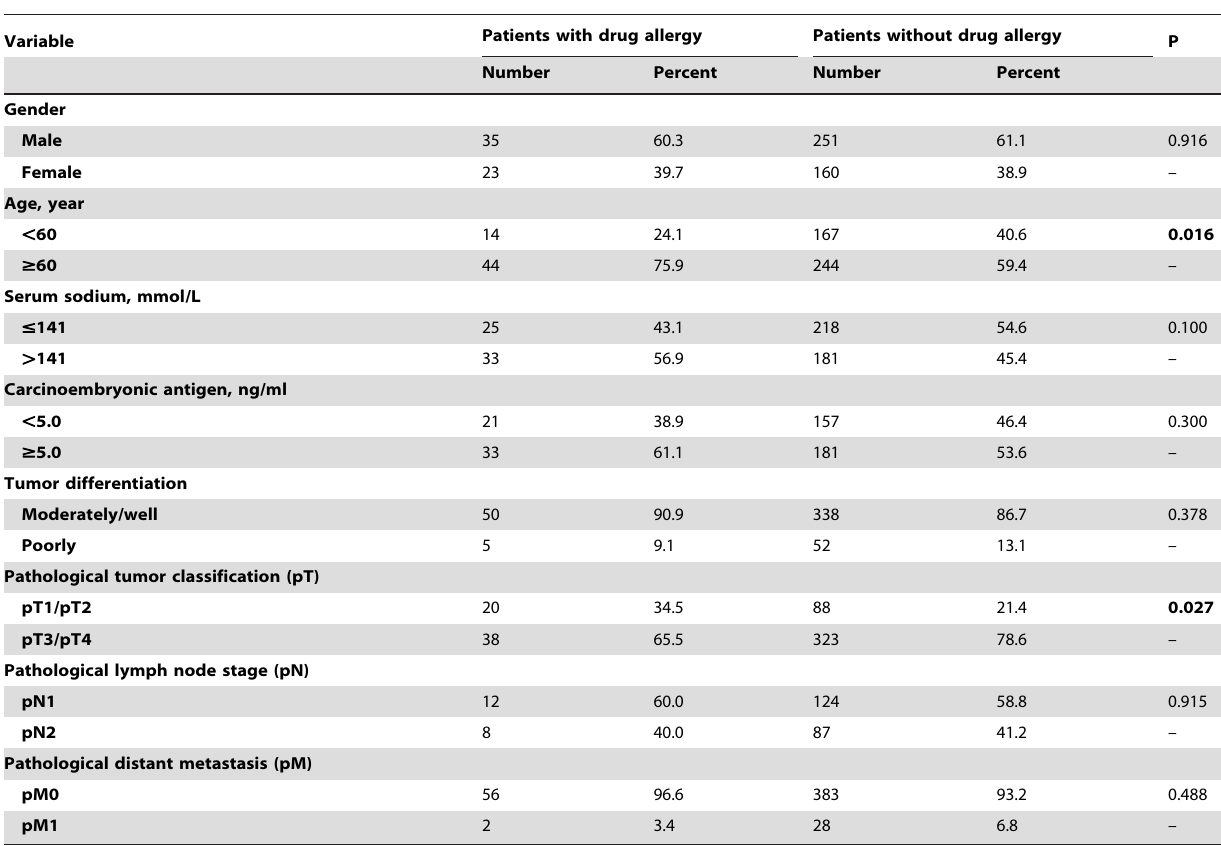
Table 4. Association between drug allergy and clinicopathological data.